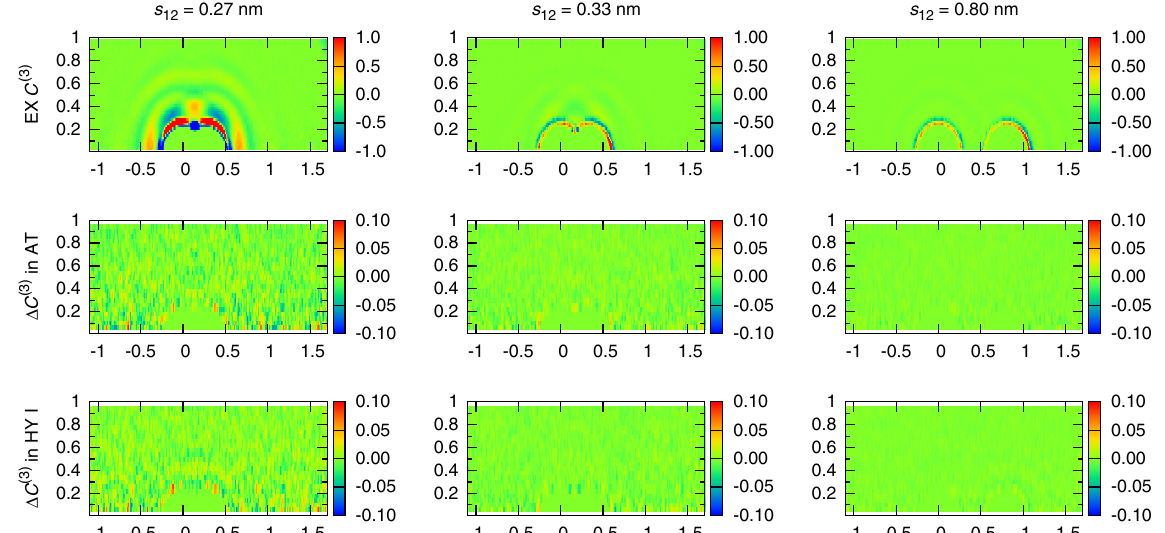
FIG. 4. The three-body correlation function C ð 3 Þ . The first row corresponds to the EX. The second and third rows show the difference between the function calculated in AdResS in the AT and HY I regions, respectively, and the reference function of the full atomistic case. Different columns give different distances between the first two molecules: From left to right, s 12 ¼ 0 : 27 , 0.33, and 0.80 nm. The horizontal axis corresponds to the variable h 1 , while the vertical axis is the variable h 2 . (See Appendix C for the definition of these variables.) The magnitude of the correlation and the differences are indicated by different